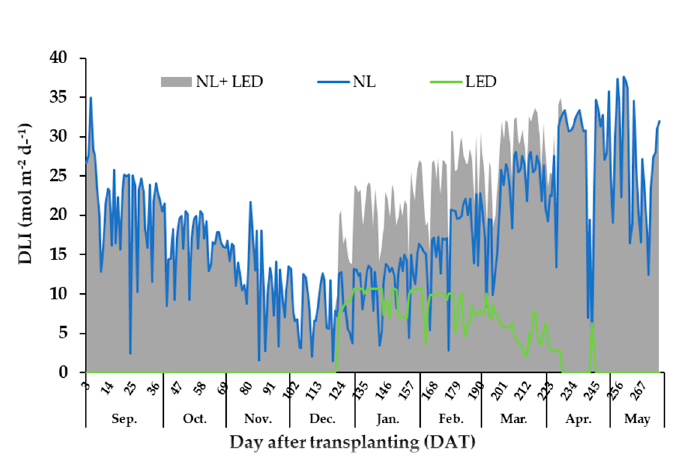
Figure 1. Daily light integral (DLI) measured in the greenhouse during the tomato plant growing cycle. Natural light (NL) + light-emitting diode (LED) is the sum of the DLI obtained from sunlight and LED, NL is the DLI obtained from sunlight, while LED is the DLI obtained from the supplemental light fixtures.